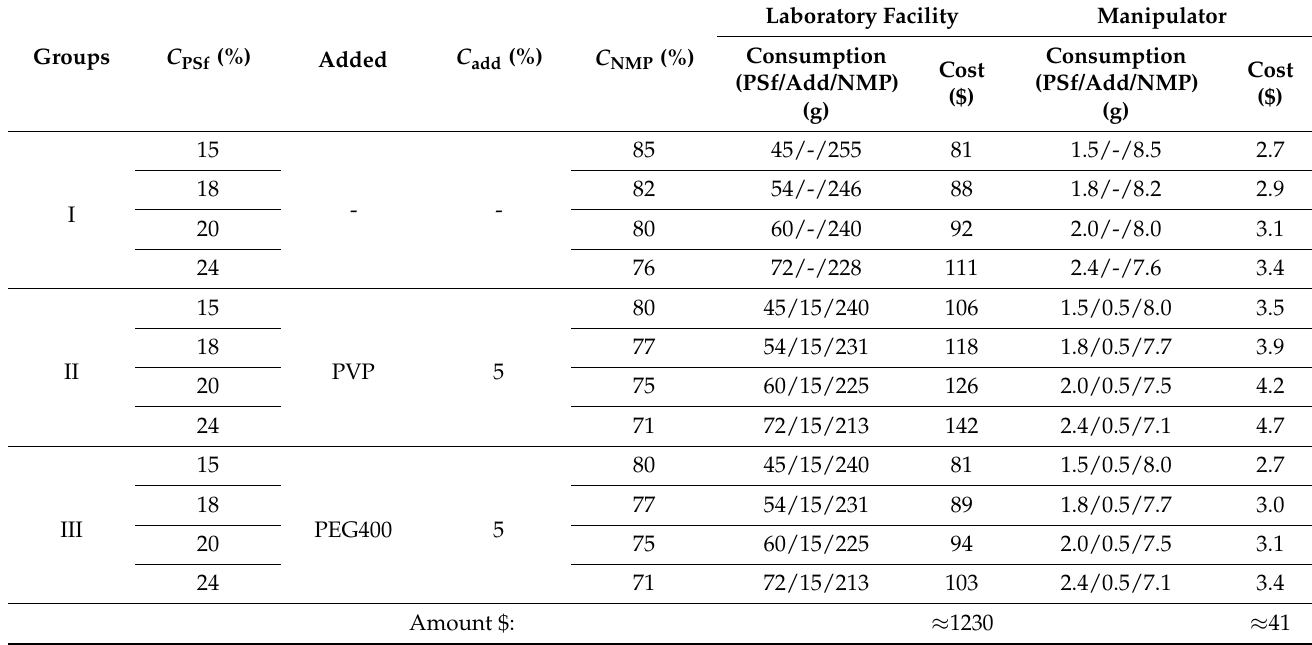
Table 7. Calculation of the cost of the components of 12 molding solutions for the manufacture of samples at the laboratory facility and on the manipulator.